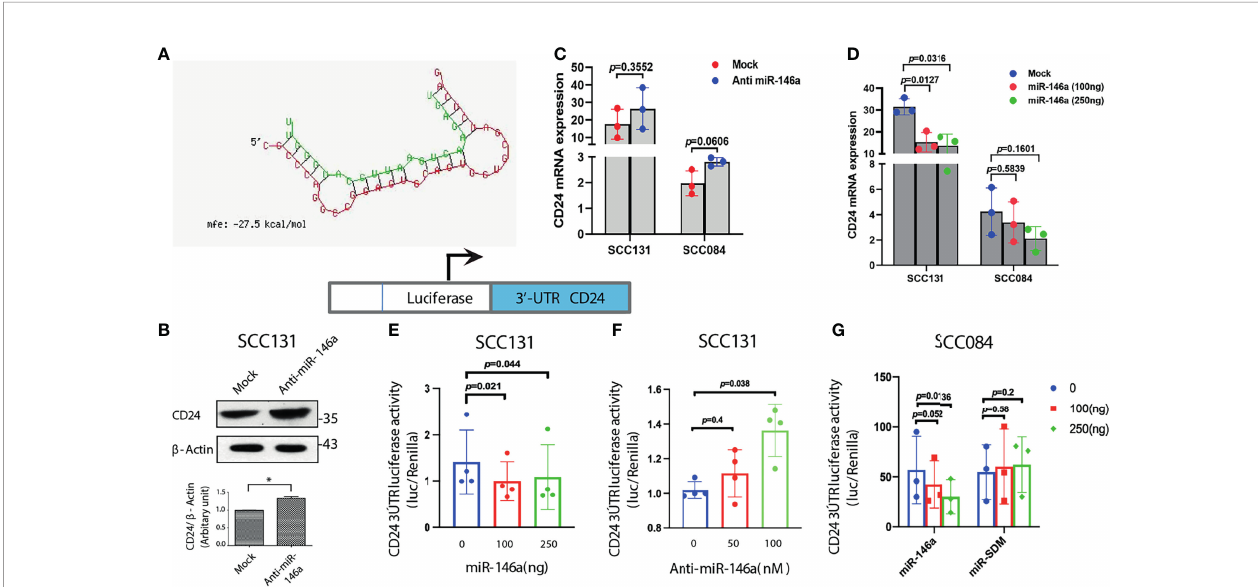
FIGURE 4 | MiR-146a targets CD24 post-transcriptionally. (A) Secondary structure prediction of CD24 3 ’ UTR base pairing with the seed sequences of miR-146a with negative free energy allowing favorable binding. (B) Immunoblotting of CD24 in SCC131 cells subjected to miR-146a knockdown showing signi fi cant up- regulation upon normalization with b -actin. (C) qRT-PCR to detect CD24 transcripts in the anti-miR-146a treated or (D) miR-146a over-expressed SCC131 and SCC084 cells.18srRNA served as an endogenous control and p-values calculated by unpaired t-test (n = 3) on delCT values that was plotted. Schematic representation of the CD24 3 ’ UTR luciferase constructs (below). (E) CD24 3 ’ UTR reporter activity upon miR-146a over-expression and (F) miR-146a knockdown in SCC131 cells. (G) Luciferase activity of the CD24 3 ’ UTR reporter gene in SCC084 cells with increasing expression of miR-146a or miR-SDM (site-directed mutant miR-146a). Data in (E – G) are mean ± SD, normalized with pRL-TK vector and statistical signi fi cance was measured by one sample t-test in GraphPad prism 8, from three or four independent